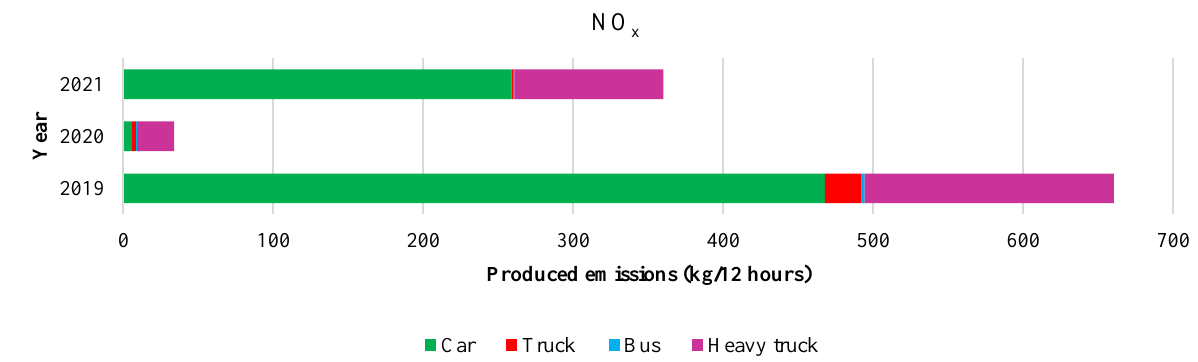
Figure 10. Estimation of NOx production during the simulation.